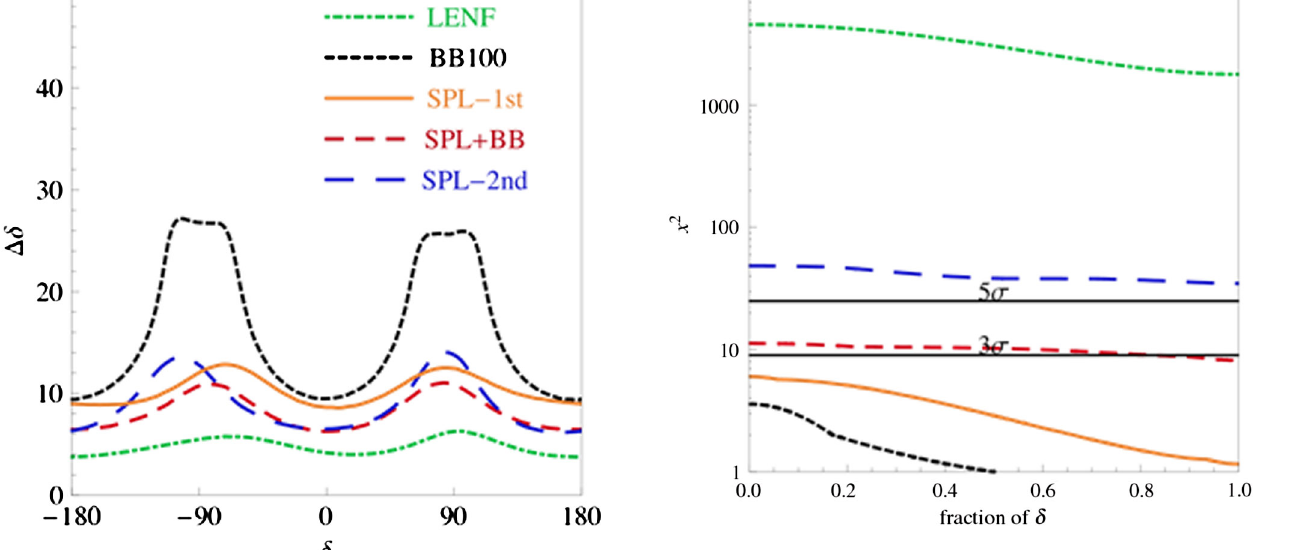
FIG. 27. The range of (cid:4) for which a 3 and 5 (cid:9) measurement of mass hierarchy can be made by for the same facilities as in Fig. 25.